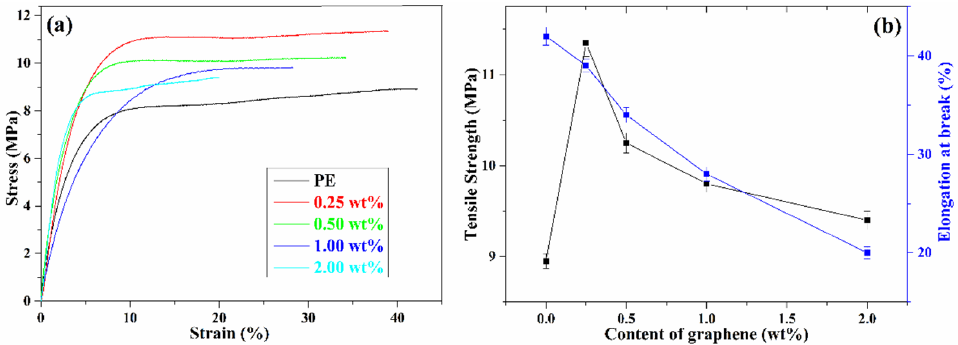
Figure 3. ( a ) Stress–strain curves and ( b ) mechanical properties of graphene/PE composites.